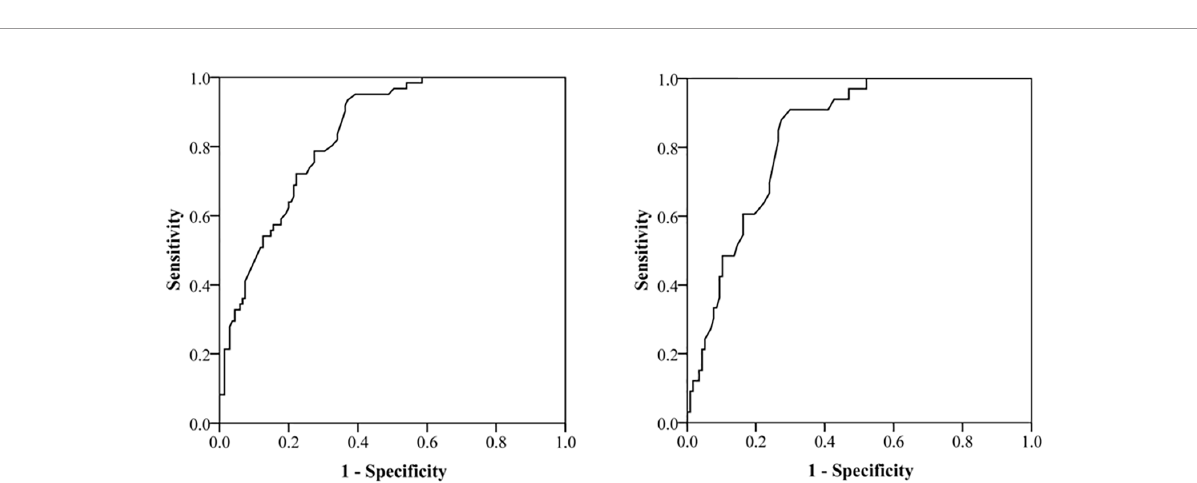
Frontiers in Oncology |